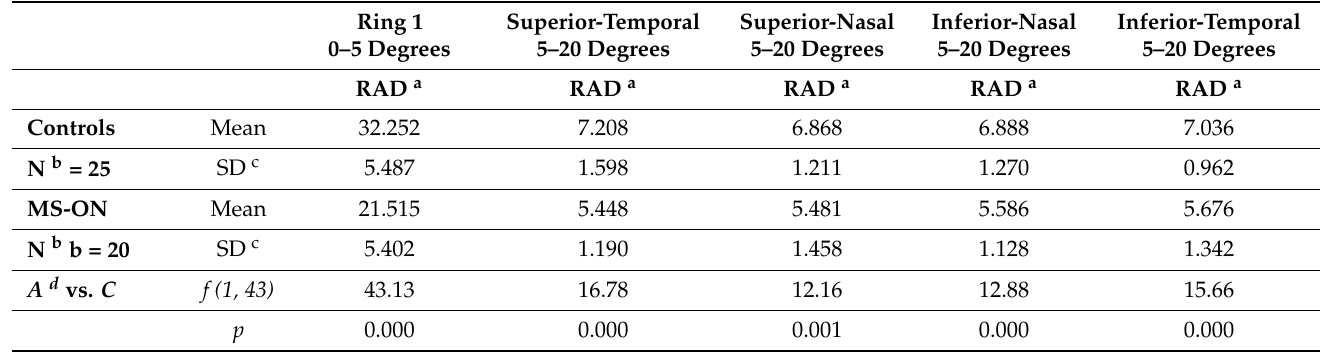
Table 3. Mean values of multifocal photopic negative response (mfPhNR) sector analysis between 5 to 20 degrees observed in controls (C) compared to multiple sclerosis patients with optic neuritis (MS ‐ ON) ones.